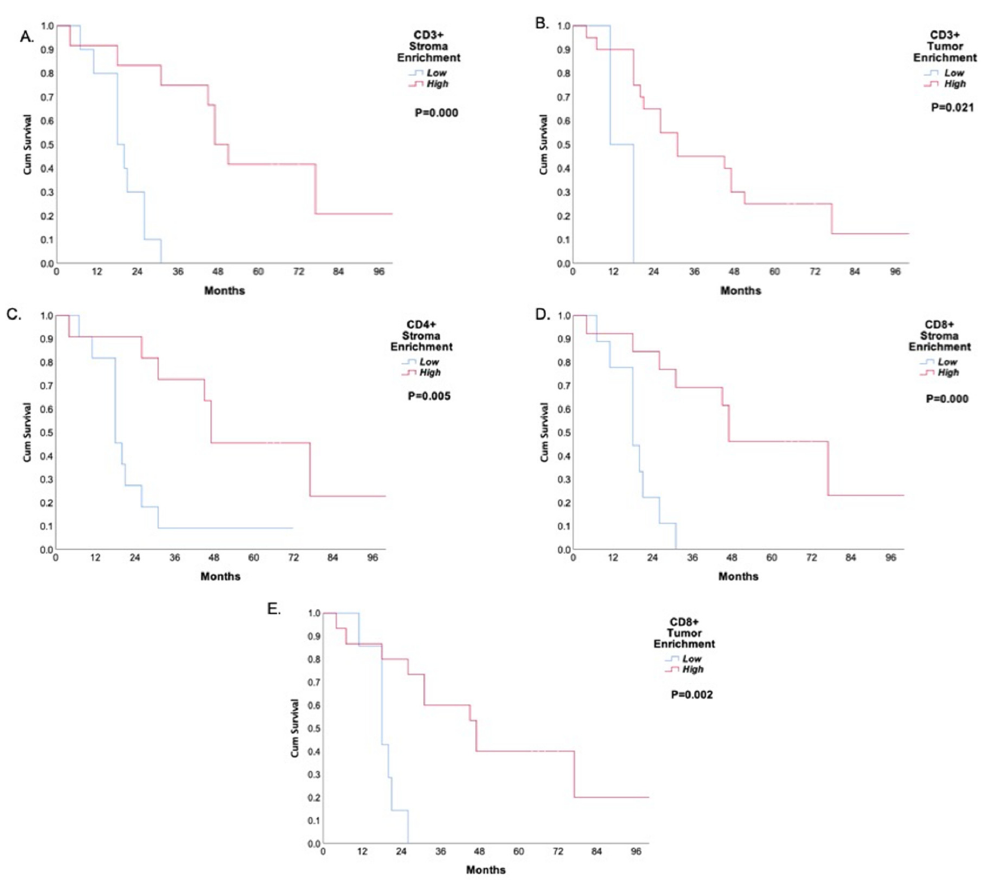
Figure 6. Kaplan–Meier curves of five-year overall survival of the neoadjuvant treated patients based on the tumor-infiltrating immune lymphocyte subpopulations. ( A ) CD3+ TIL stroma; ( B ) CD3+ TIL tumor; ( C ) CD4 + TIL stroma; ( D ) CD8+ TIL stroma; ( E ) CD8+ TIL tumor. Table 2. Cox regression analysis for disease-free survival ( A ) and overall survival ( B ). LN—lymph node; mets—metastases; T—T stage; CR—complete response. Univariate Analysis Multivariate Analysis Characteristics